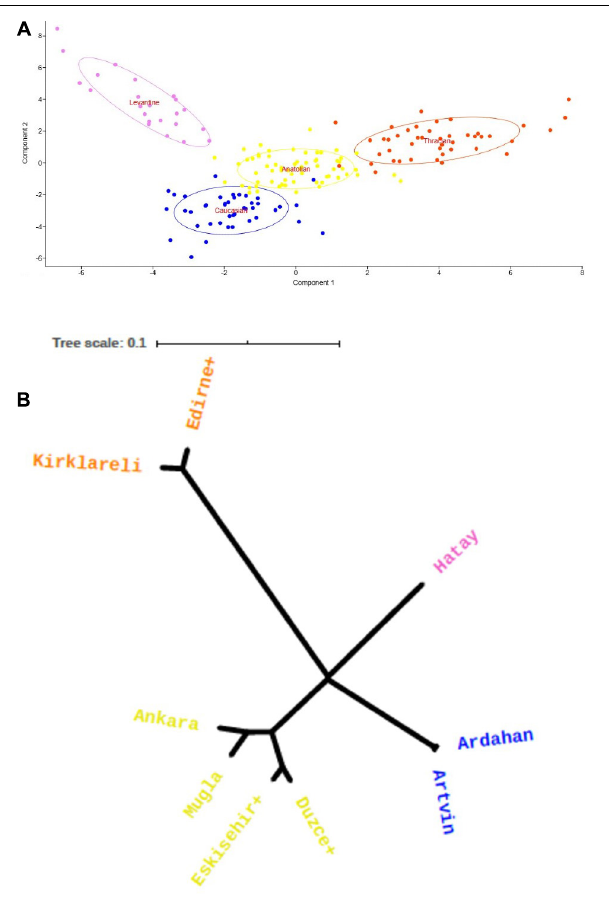
FIGURE 2 | (A) Principal component analysis (PCA) of stationary colonies with 66% concentration ellipses shown. Component 1 and Component 2 explain 41.8 and 32.1% of the variance within the samples, respectively. The first axis differentiated samples in Thrace indicating strong divergence between those and others whereas the second axis differentiated subspecies throughout Anatolia. Each dot represents an individual (orange: C-lineage subspecies in Thrace; O-lineage subspecies: yellow: anatoliaca , blue: caucasica , violet: syriaca ). (B) UPGMA tree of honey bee populations based on Reynolds, Weir, and Cockerham’s genetic distances. Tree resolves four distinct branches corresponding to four subspecies. Thracian populations constitute the extreme end of the unrooted tree. The other end is divided into three almost equidistant branches of Caucasian, Levantine, and Anatolian